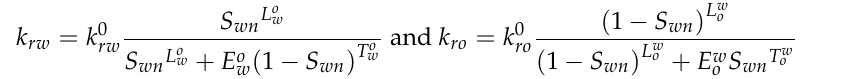
Figure 1. Base case permeability field — 500 × 500 cells, 𝜆 𝐷 = 0.03.